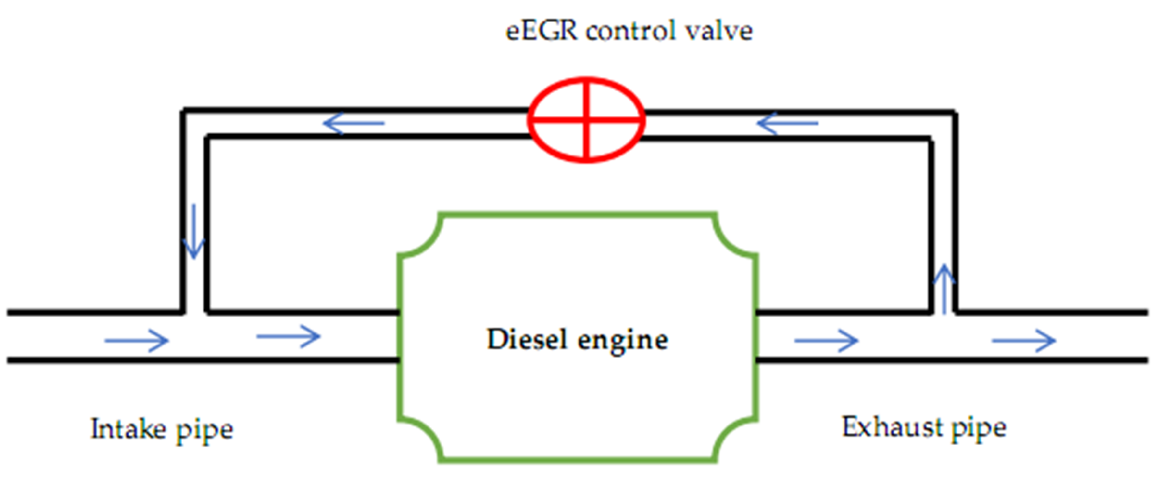
Figure 10. A simple eEGR loop system.